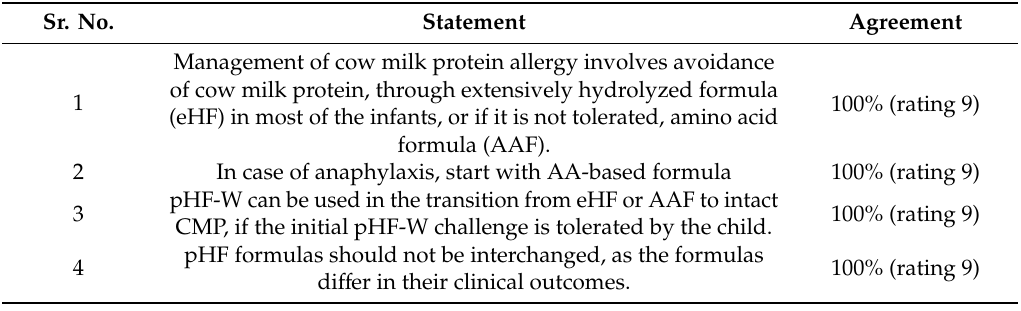
Table 3. Consensus statements on cow’s milk protein allergy (CMPA) treatment: The Middle-East step-down approach.